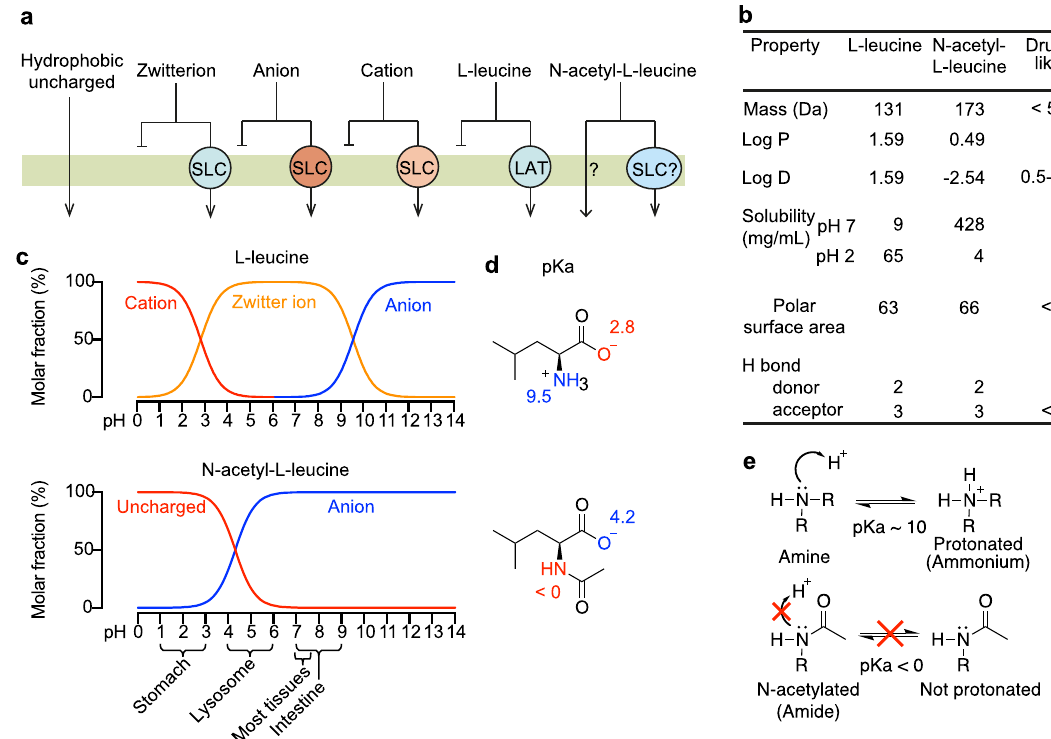
Figure 1. The effects of N -acetylation on the chemical properties and pharmacological consequences of the drug N -acetyl-l-leucine. ( a ) Mechanisms of absorption illustrated by crossing a membrane by passive diffusion or carrier-mediated uptake. In general, hydrophobic uncharged molecules can cross lipid bilayer membranes through simple passive diffusion, whereas charged molecules including zwitterions (a positive and negative charge within the same molecule), anions and cations cannot cross membranes without a transporter. Over 400 Solute Carrier (SLC) transporters are known with broad but overlapping selectivities for substrate. l-leucine as an obligate zwitterion at all biologically relevant pH values has an absolute requirement for its carrier, the high- affinity l-type amino Acid Transporter (LAT1). In contrast, N -acetyl-l-leucine can exist as a neutral species and passively cross membranes at low pH, or as an anion recognized by other transporters. ( b ) Comparison of the physicochemical properties of l-leucine and N -acetyl-l-leucine relating to oral bioavailability. ( c ) Speciation curves for the protonation states of l-leucine and N -acetyl-l-leucine. The gross charge distribution of a molecule as a function of pH is calculated as well. The dominant species is indicated in several tissues relevant to drug absorption and distribution. ( d ) Chemical structures showing charge at pH 7 with the pK a of the amino and carboxylic acid groups labelled. ( e ) Lewis structures illustrating the effect of N -acetylation on the pK a of nitrogen atom. Resonance delocalization of the lone pair electrons in the amide greatly decreases the basicity of the nitrogen relative to the amine, making the molecule neutral or charged,